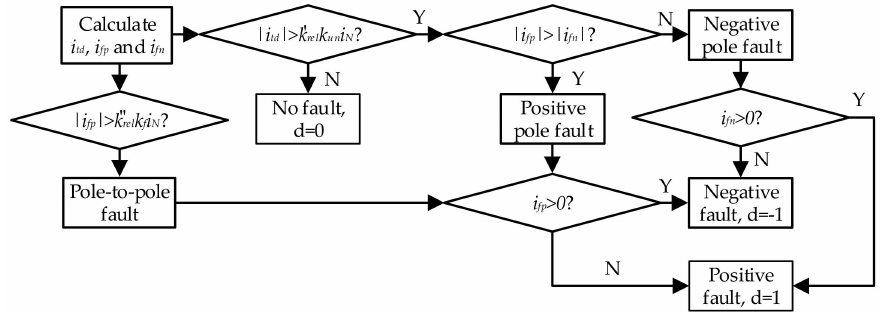
Figure 6. The flowchart for directional element of